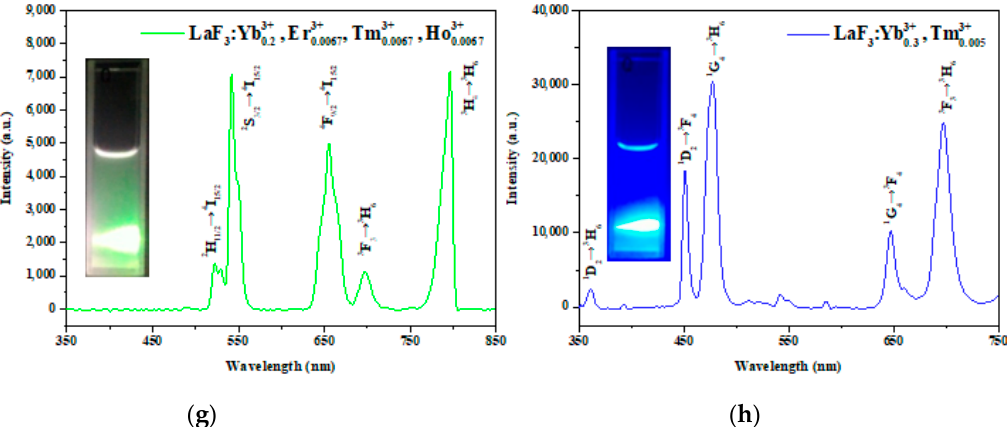
Figure 5. Photoluminescence spectra of LaF 3 :Yb 3+ /Er 3+ /Ho 3+ /Tm 3+ core nanoparticles with different mole concentrations of Er 3+ , Ho 3+ , and Tm 3+ under 980 nm near-infrared (NIR) irradiation. The inset in each figure is the corresponding luminescence photograph of the core UCNP in the solution.